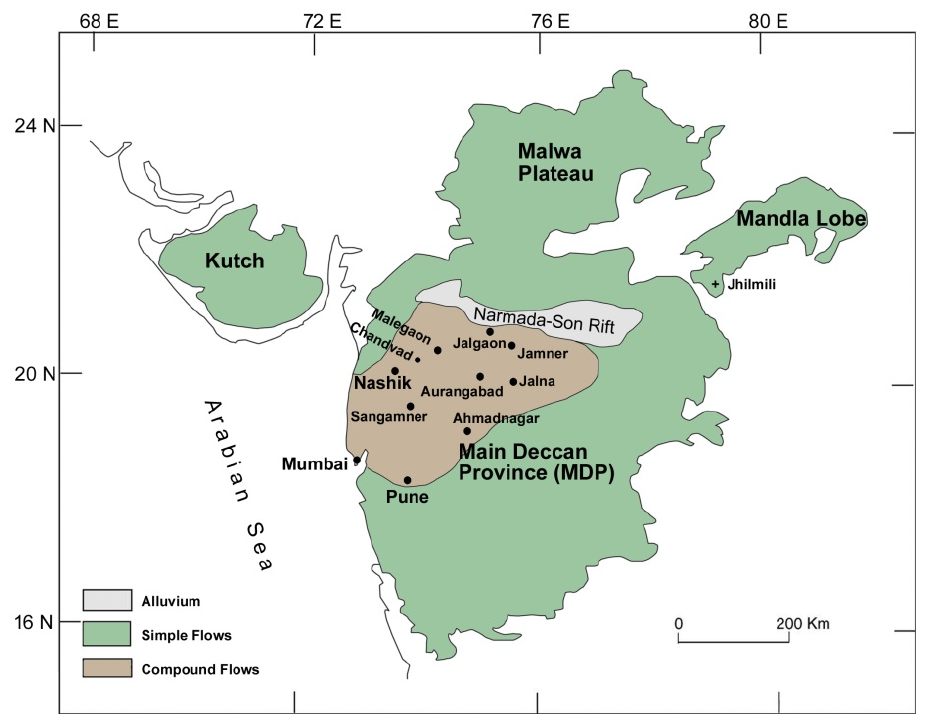
Figure 1. Map of the Deccan Volcanic Province (DVP) with the four main divisions and the most important sites of discovery of subsurface filamentous fabrics (SFF) occurrence in the compound lava flows of the Main Deccan Province (MDP).